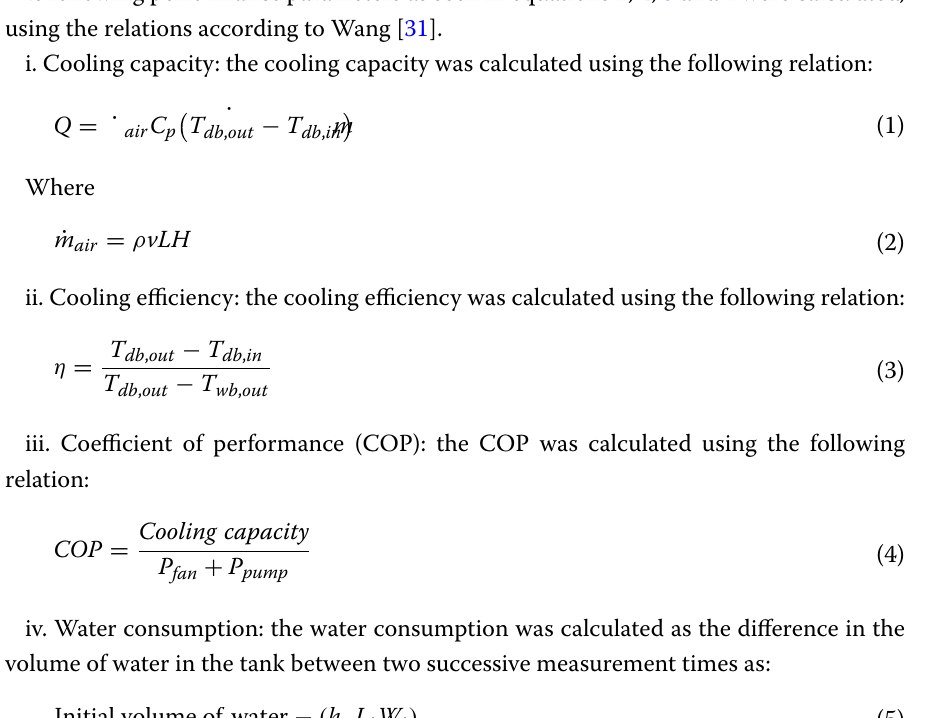
Table 3 Specification of measuring instruments Parameter Apparatus Model. no. Accuracy Measuring range Dry bulb temp. Digital thermocouple thermometer T407291 0.1 o C Wet bulb